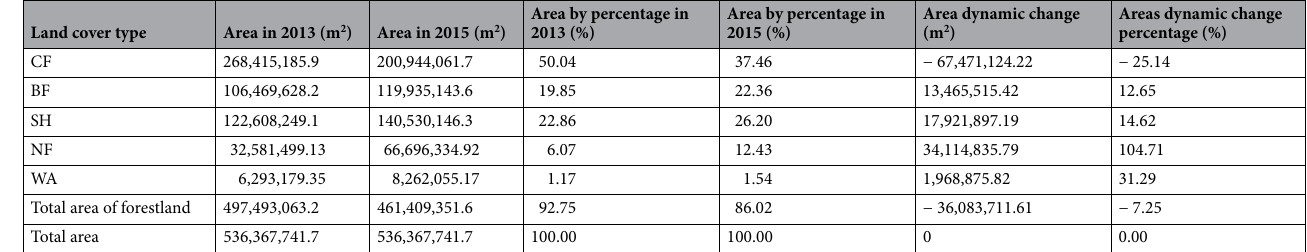
Table 2. Statistical dynamic land cover changes statistical data for 2013 and